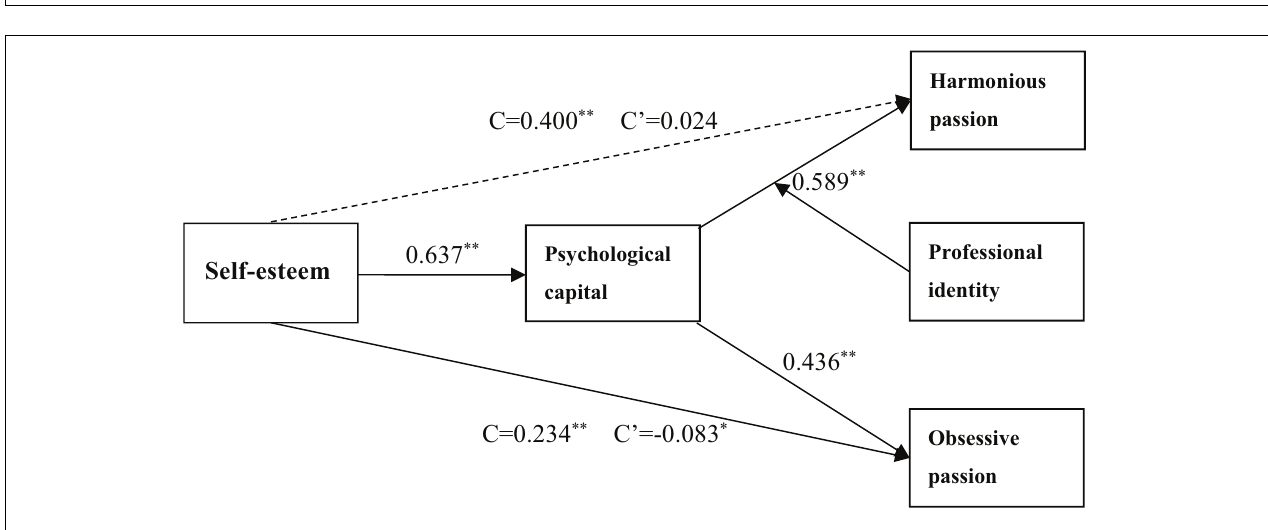
FIGURE 2 | Moderator effect of professional identity on the relationship between PsyCap and harmonious learning passion.